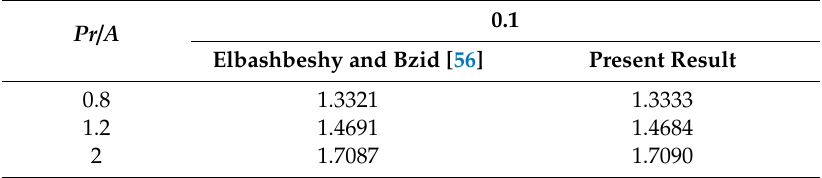
Table 2. Comparison of − f (cid:48)(cid:48) ( 0 ) with Elbashbeshy and Bzid [56] when β = M = K 1 = Ec = A 1 = ε =